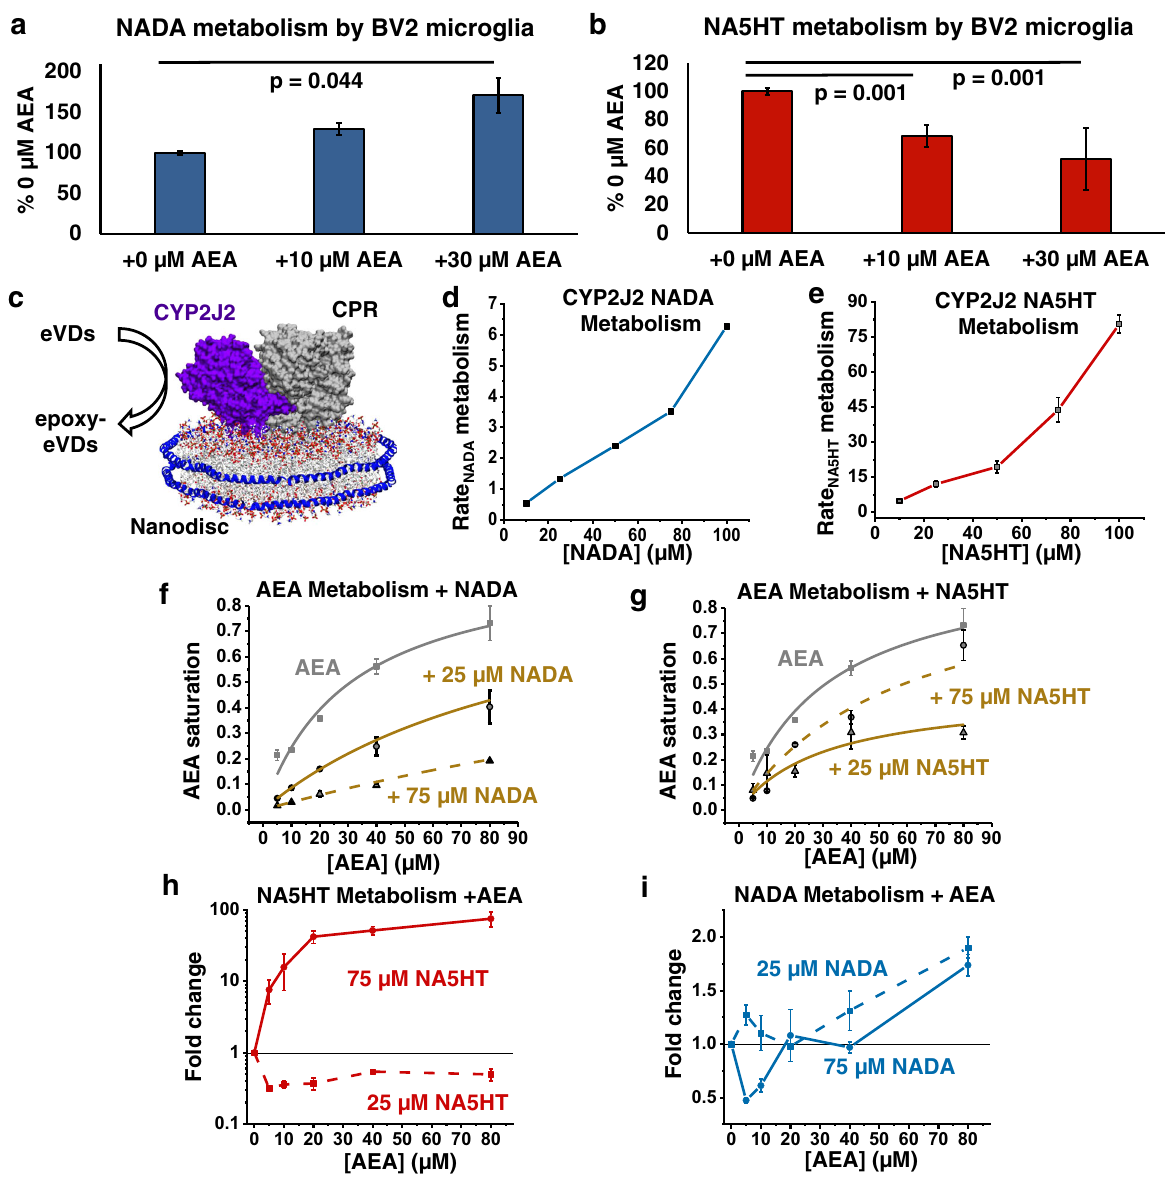
Fig. 3 Potentiation of eVD metabolism by AEA. a Metabolism 10 µ M NADA and b 10 µ M NA5HT in the presence of increasing concentrations of AEA by BV2 microglia. Metabolism was conducted similarly to data in Fig. 2c. Data shown are the mean ± SEM of n = 6 (two sets of triplicate performed on separate days). Statistical signi fi cance is based on a one-way ANOVA with a Tukey ’ s post-hoc. c Schematic of the CYP2J2-CPR-Nanodisc. d , e Metabolism of NADA and NA5HT by CYP2J2-CPR-NDs. Rates are in pmol epoxy-eVD min − 1 nmol CYP2J2 − 1 and data represents the mean ± SEM of three independent experiments. f – i Co-substrate metabolism of eVDs with AEA. f AEA metabolism in the presence of NADA and g NA5HT. Rates are shown as the fraction of the V max (135 pmol EET-EAs min − 1 nmol CYP2J2 − 1 ) for AEA metabolism (gray squares) as previously published (see text). h Fold change of NA5HT metabolism and i NADA metabolism in the presence of increasing AEA concentrations compared to the metabolism without AEA. f – i Data represents the mean ± SEM of three independent experiments. All data can be found in the Source Data fi